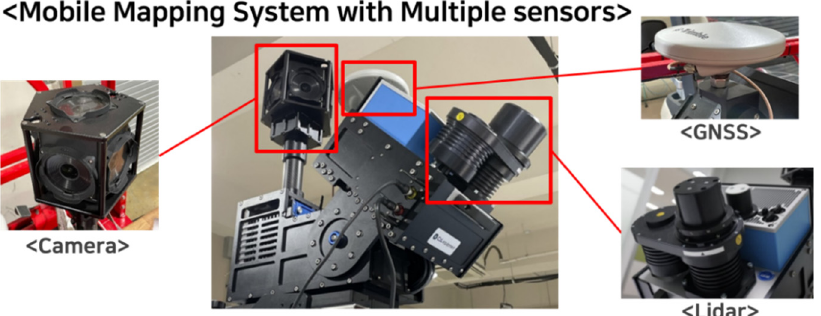
Figure 2. Mobile mapping system (MMS) with multiple sensors.